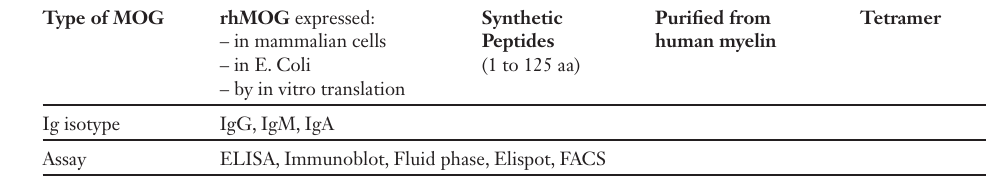
Table 2 Summary of MOG preparations and assays used for anti- MOG Abs detection in